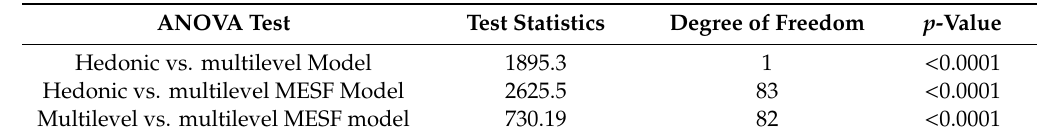
Table 4. Summaries of ANOVA test